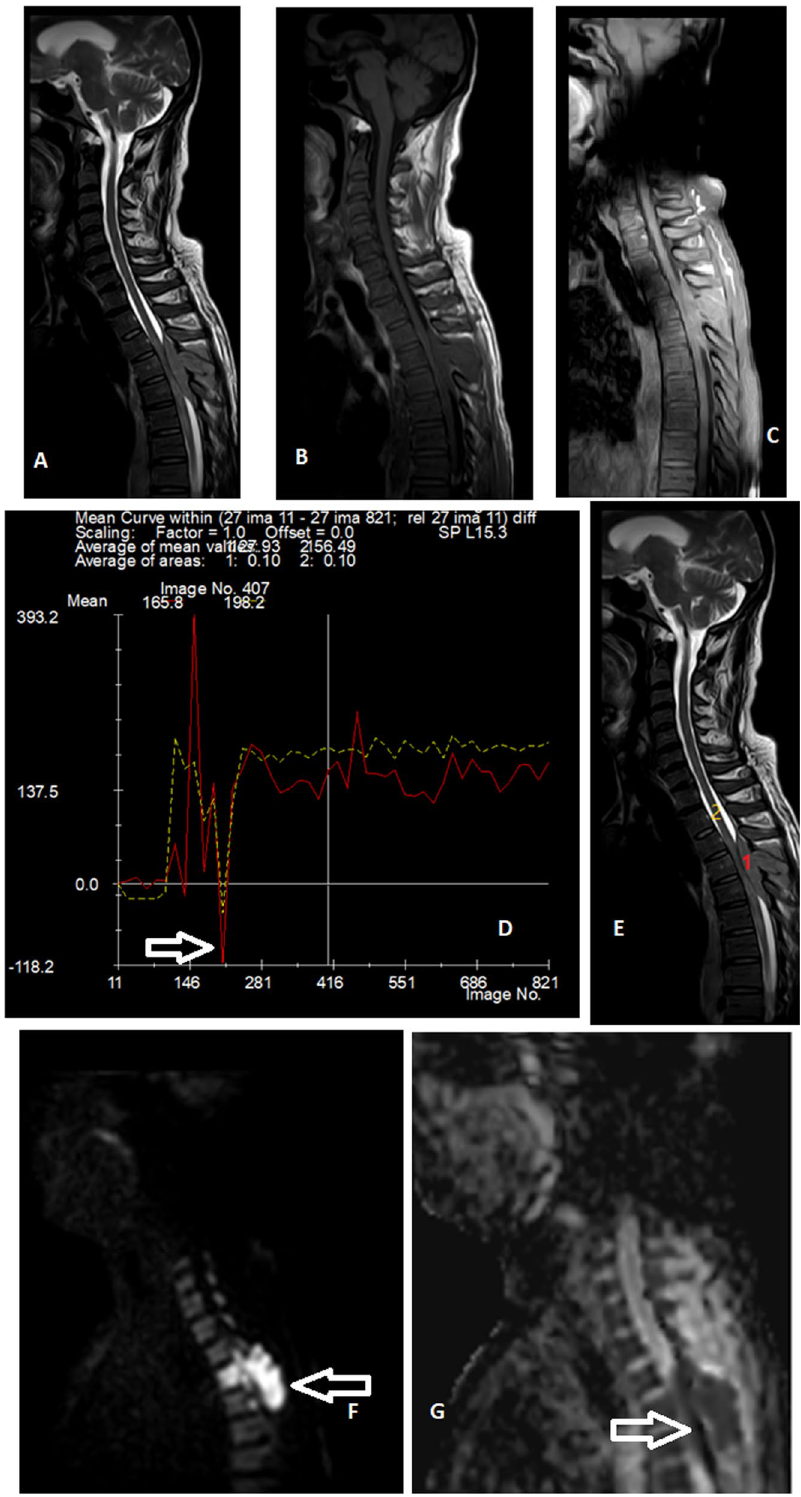
Fig. 1 46-y-old male was complaining of low back pain. T2 sagittal cervico-dorsal spine ( A ) shows extra ‑ medullary soft tissue of isointense signal opposite D3-D7. Pre-contrast T1 ( B ) and post-contrast T1 ( C ) show intense enhancement of the lesion. D and E rCBV was measured in comparison to normal cord (yellow curve) and the curve shows hyper perfusion of the lesion (arrow to red curve). DWI at b value of the lesion (arrow) which looks hypointense at ADC map (arrow at G ) denoting restricted diffusion. This lesion was diagnosed as spinal